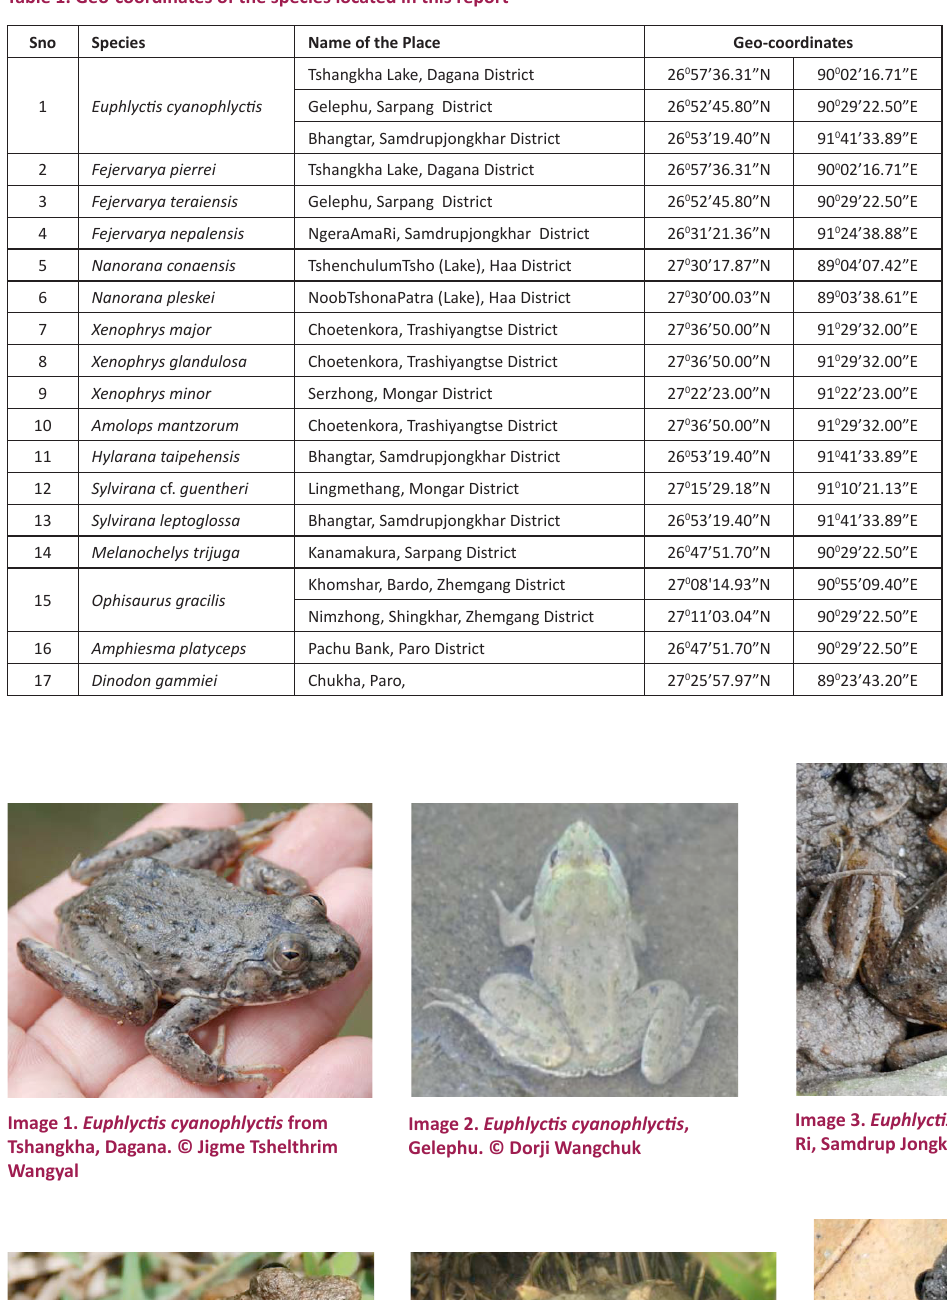
Table 1. Geo-coordinates of the species located in this report